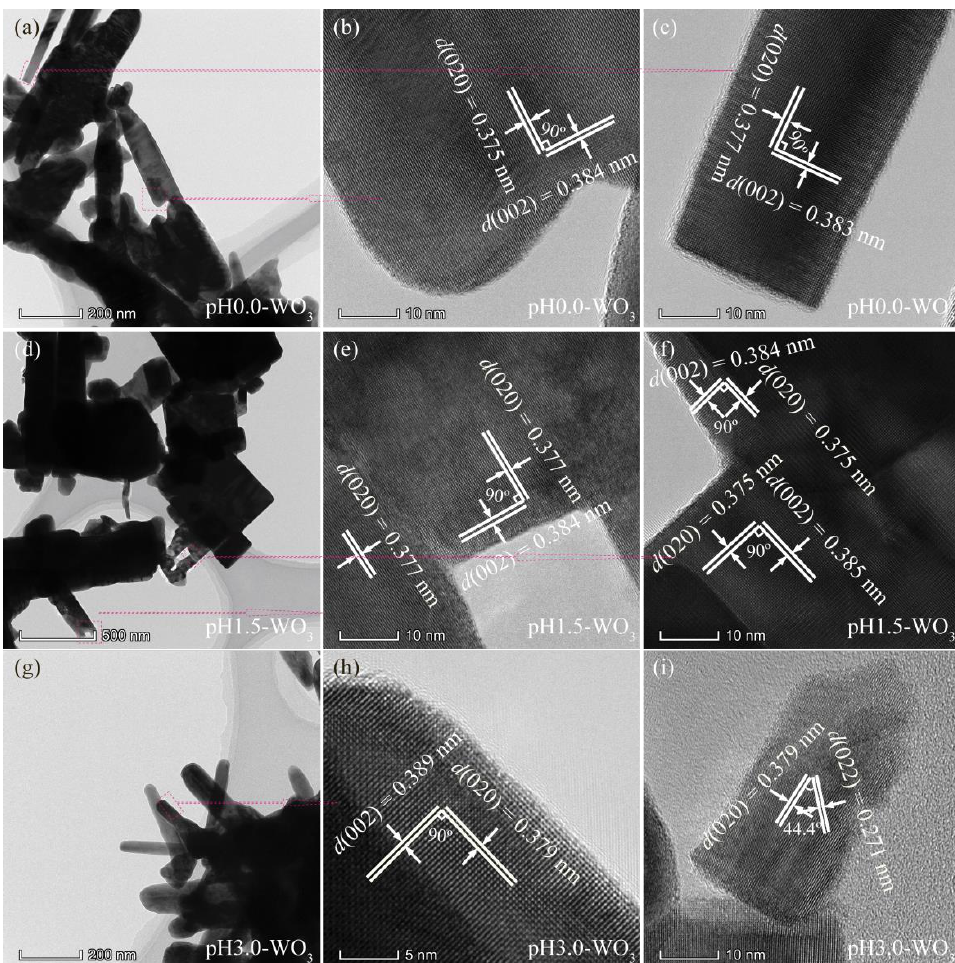
Figure 4. TEM and HRTEM images for: ( a – c ) pH0.0-WO 3 , ( d – f ) pH1.5-WO 3 , and ( g – i ) pH3.0-WO 3 . The pH5.0-WO 3 sample consists of a large amount of irregular morphology nano- crystals with a size of 18~106 nm, as shown in Figure 5a. The corresponding HRTEM images (Figure 5b,c) show that the distances of the visible lattice fringes over a large area were measured to be 0.525, 0.389, and 0.375 (or 0.378) nm, which are in agreement with the lattice spacing of (110), (002) and (020) atomic planes of the monoclinic structure of WO 3 . In addition, the (110) and (002) crystal planes parallel to the sides of the irregular nanocrystal with an interfacial angle of 89.3°, indicating that the irregular nanocrystal with co-exposed of {110} and {002} facets on its sides, as shown in Figure 5b. Irregu- lar-shaped WO 3 nanocrystals with a size of 18 – 86 nm were observed in the TEM image of the pH7.0-WO 3 sample, as shown in Figure 5d. The HRTEM images (Figure 5e,f) show that the distances of the visible lattice fringes over a large area were measured to be 0.263 and 0.375 nm, which are in agreement with the lattice spacing of (202) and (020) atomic planes of the monoclinic structure of WO 3 . Furthermore, the interfacial angle between (202) and (020) crystal planes is 90°, which is consistent with the theoretical